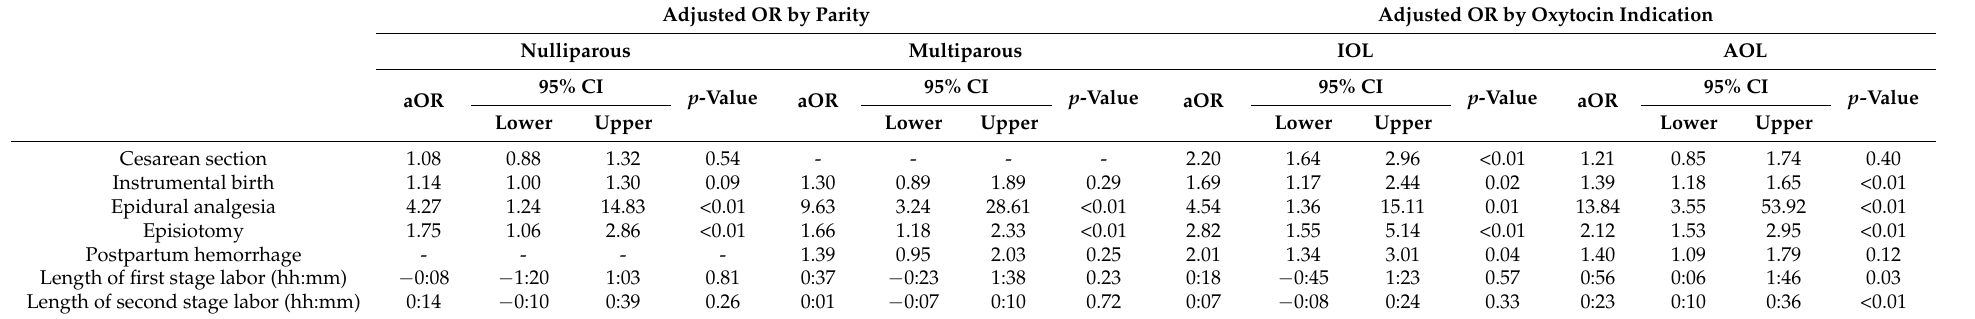
Table 3. Adjusted OR for birth outcomes with oxytocin as a predictor by parity and oxytocin indication. Adjusted OR by Parity Adjusted OR by Oxytocin Indication Nulliparous Multiparous